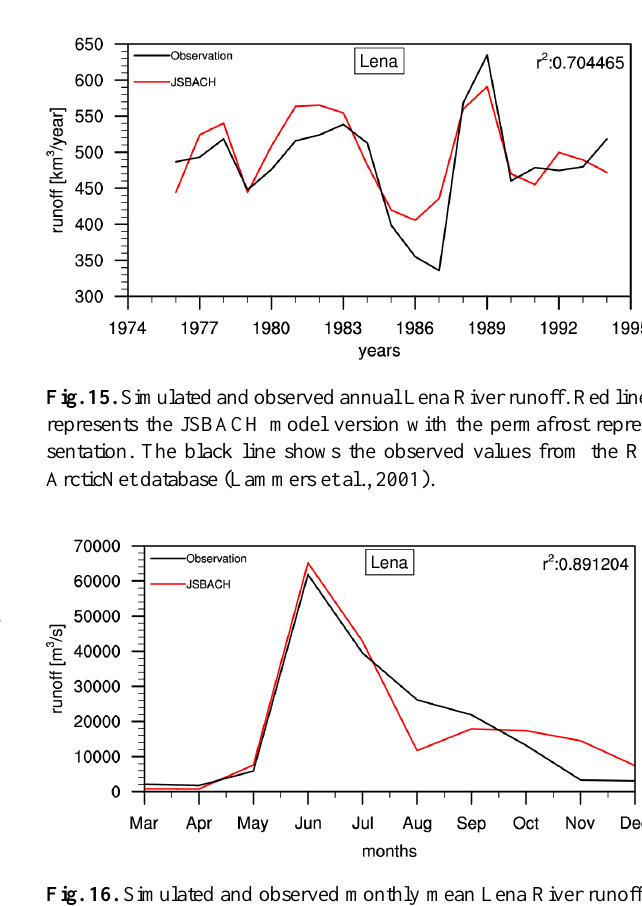
Fig. 16. Simulated and observed monthly mean Lena River runoff. Line colors are the same as annual runoff plot (red: model values; black: observed values). Since the model does not use a river routing scheme, the model results are shifted 2 months to match the actual peak time in